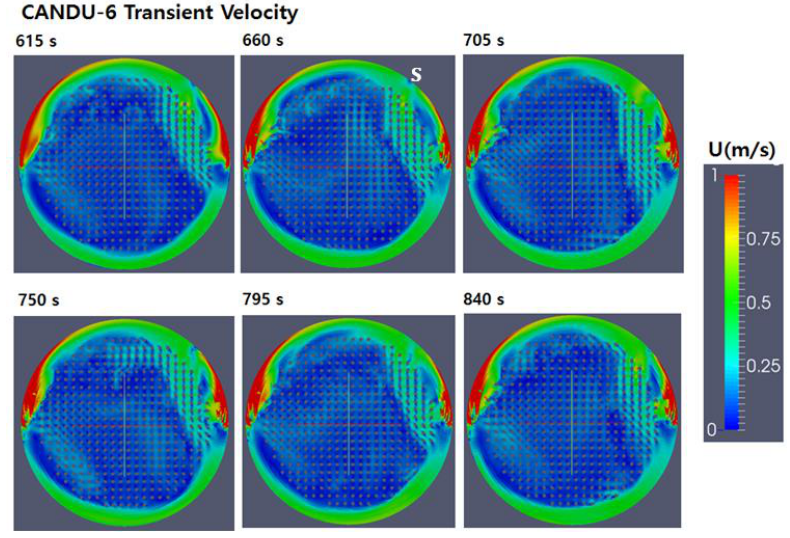
Figure 7. Velocity distribution at z = 0; 615 – 840 s.